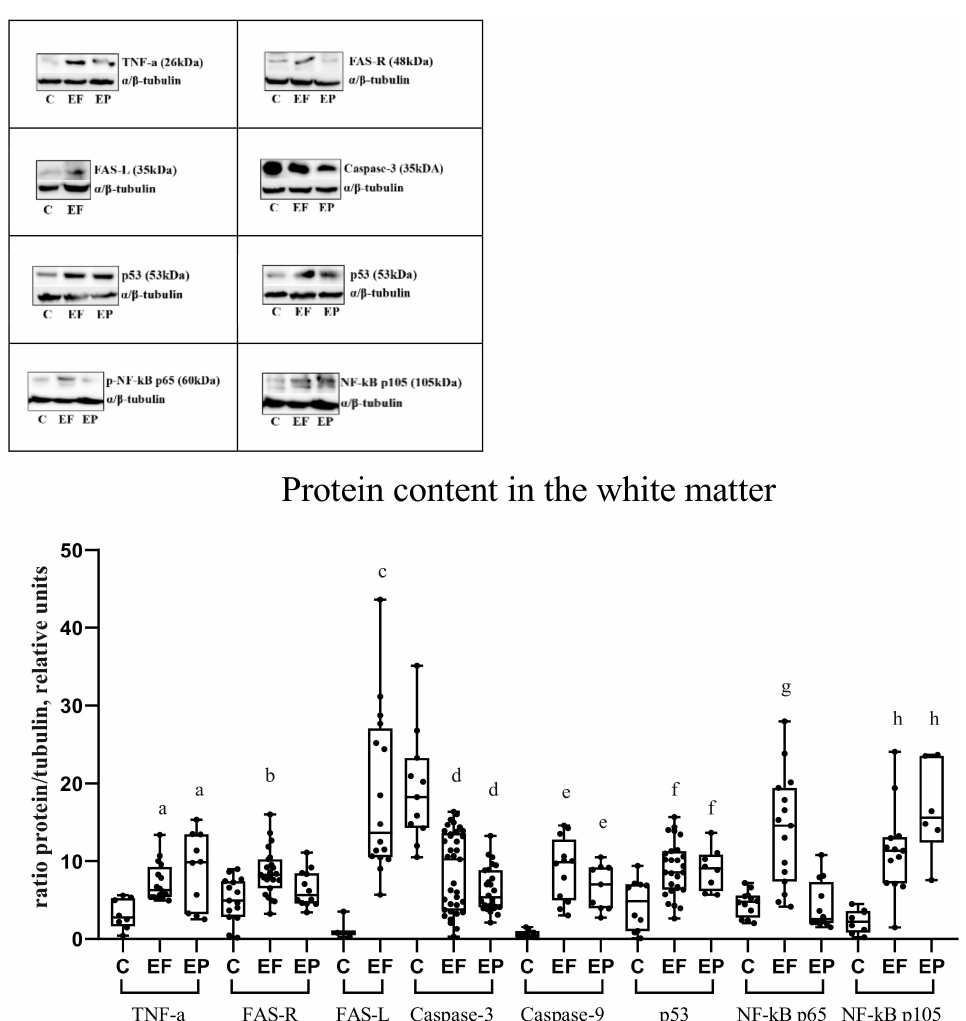
Figure 5. Content of TNF- α , FAS-R, FAS-L, caspase-3, caspase-9, p53, p-NF-kB p65, p-NF-kB p105 in the white matter of the temporal lobe of the brain. Lysates of human white matter biopsy were studied on a 10% polyacrylamide gel by Western blot. C, control group; EF, epileptic focus; EP, perifocal zone. Significant differences: a-differences in the content of TNF- α protein in the white matter compared with the control group, statistically significant at p < 0.05; b, differences in the content of FAS-R protein in the white matter compared to the control group, statistically significant at p < 0.05; c, differences in the content of FAS-L protein in the white matter compared with the control group, statistically significant at p < 0.05; d, differences in the content of caspase-3 protein in the white matter compared to the control group, statistically significant at p < 0.05; e, differences in the content of caspase-9 protein in white matter in comparison with the control group, statistically significant at p < 0.05; f, differences in the content of p53 protein in the white matter in comparison with the control group, statistically significant at p < 0.05; g, differences in the content of p-NF-kB p65 protein in white matter compared to the control group, statistically significant at p < 0.05; h, differences in the content of NF-kB p105 protein in white matter compared to the control group, statistically significant at p <